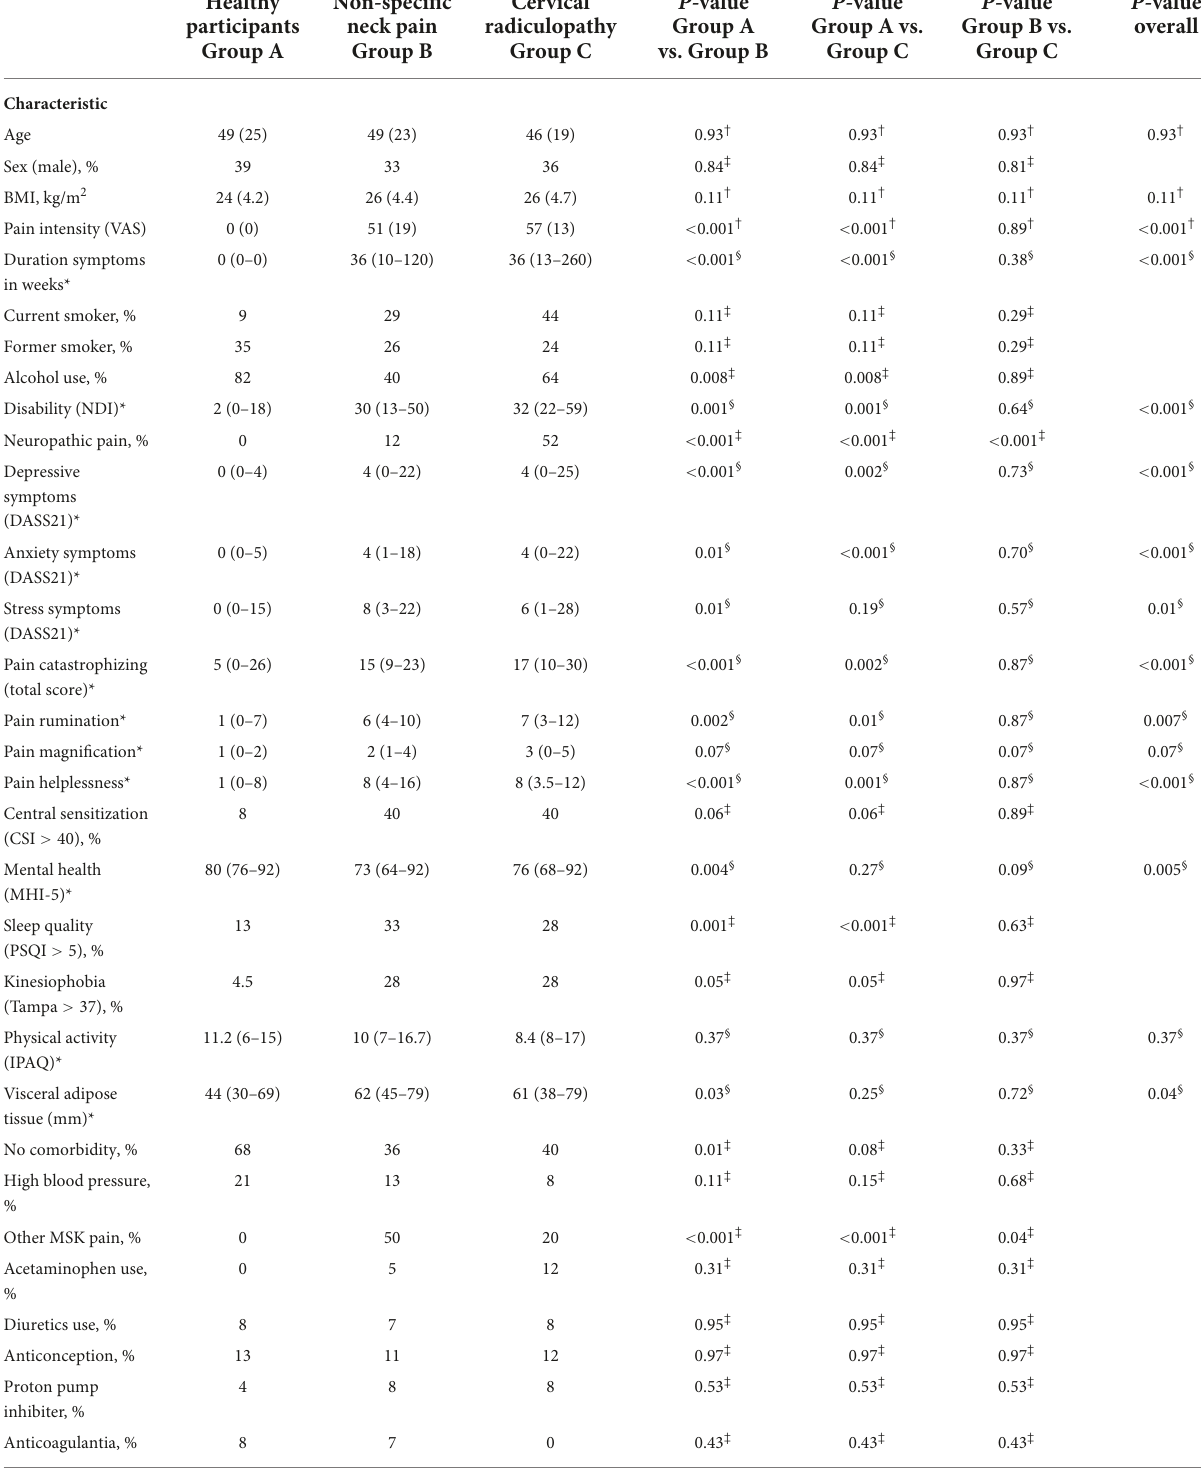
TABLE 3 Demographic and clinical